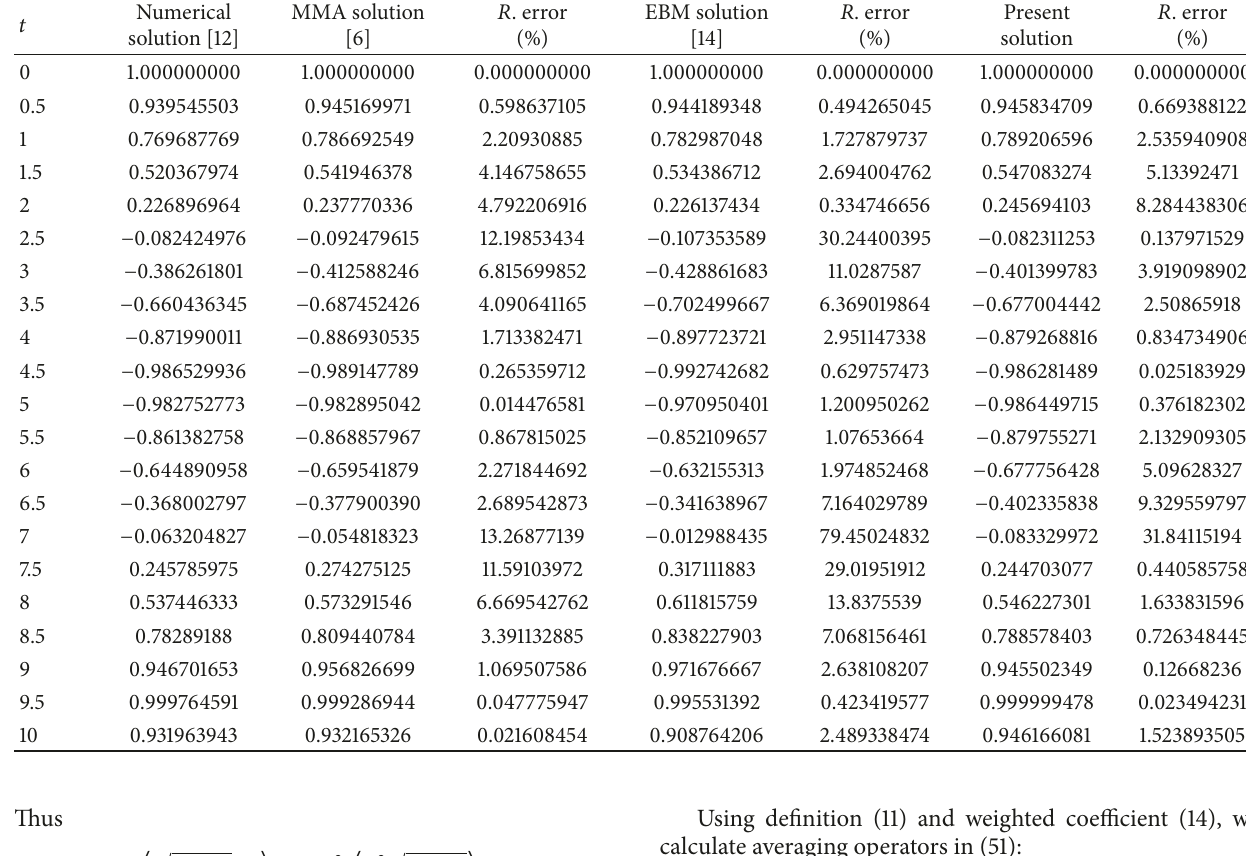
Table 2: The results of present, approximate, obtained by Jouybari & Ramzani and by Yousesian et al., and numerical solution for 𝜃(𝑡) when Λ = 0.75 and 𝐴 = 1 , Example